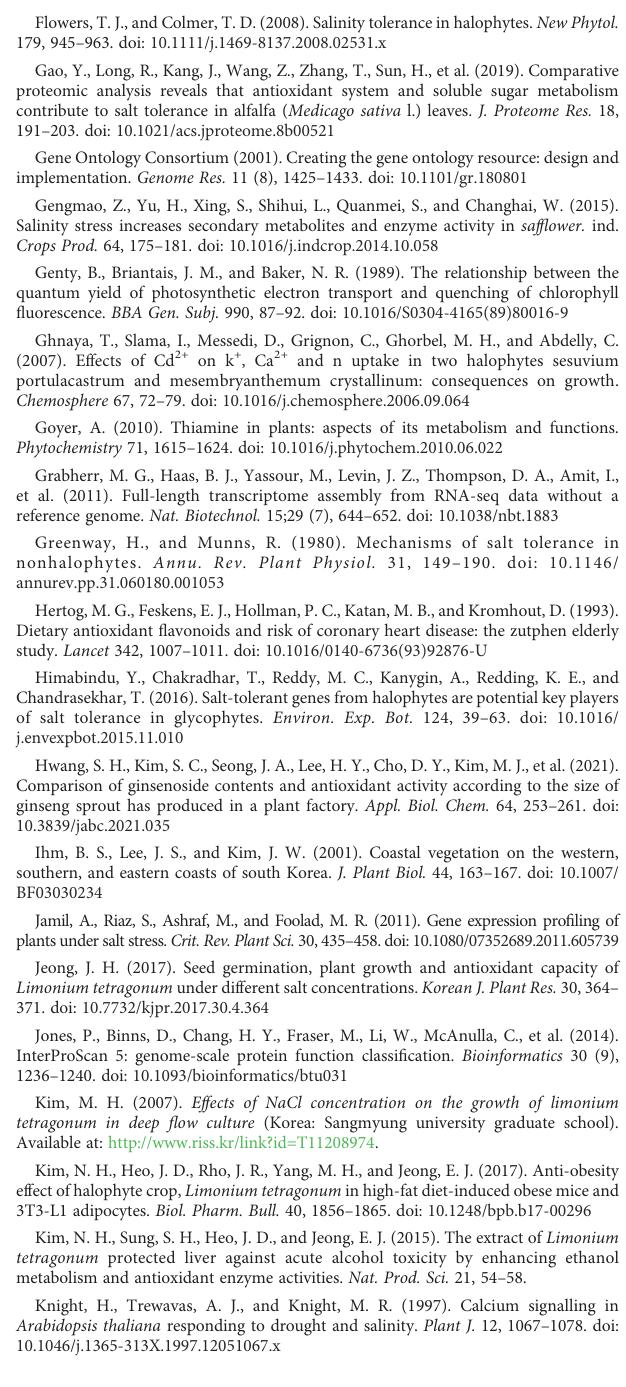
SUPPLEMENTARY FIGURE 2 The growth of L. tetragonum under different NaCl concentrations. SUPPLEMENTARY TABLE 1 Composition of Hoagland ’ s nutrient solution used in the cultivation of Limonium tetragonum . SUPPLEMENTARY TABLE 2 NaCl components and chemical property for L. tetragonum under different NaCl concentrations used in this